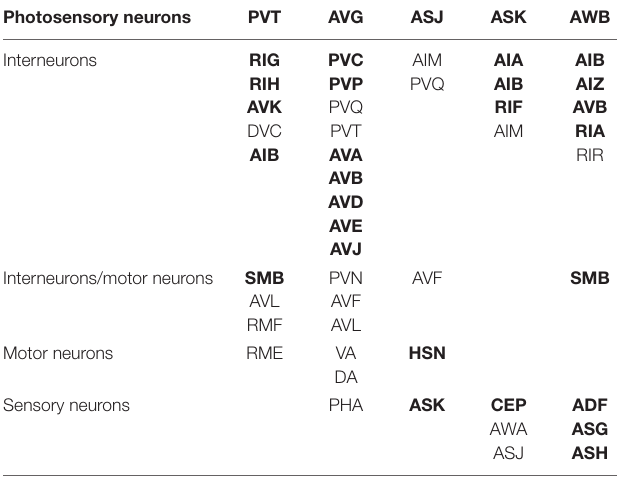
TABLE 1 | Neurons involved in photosensory